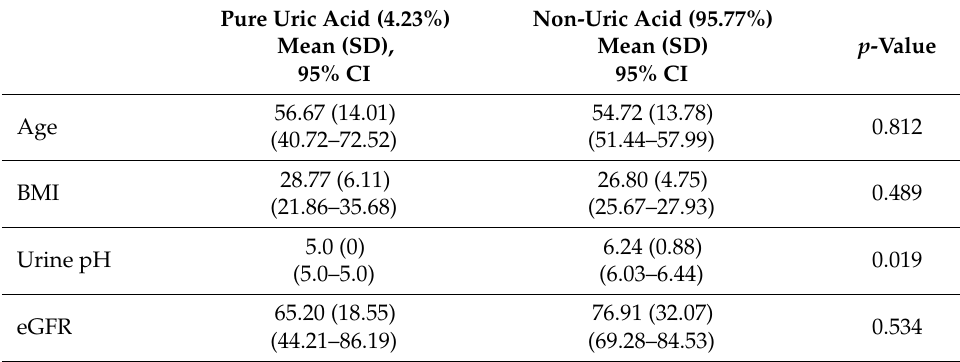
Table 4. Age, BMI, urine pH, and eGFR of all study samples in Cohort B. Pure Uric Acid